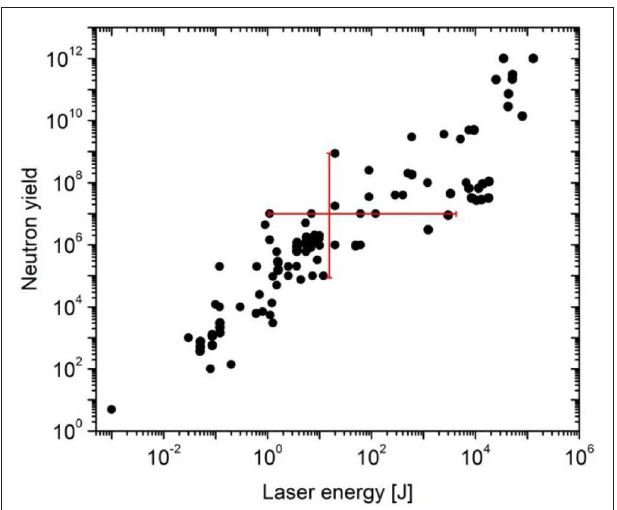
FIGURE 1 | Neutron yields from deuterated targets irradiated by various laser systems, data from References [ 1–3, 10, 14, 17–35]. Pitcher-catcher configurations are not displayed. In the case of anisotropic neutron emission, equivalent 4 π neutron yields were calculated from peak neutron